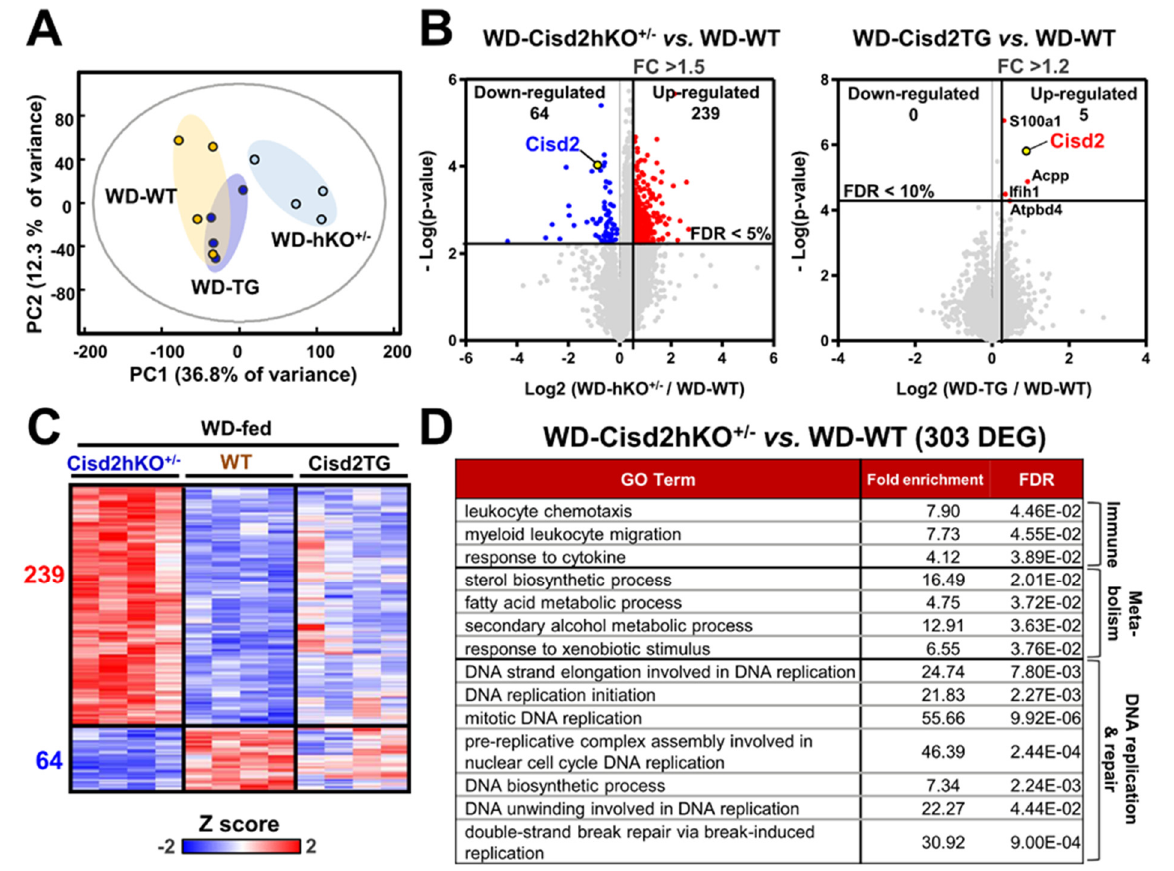
Figure 3. Cisd2 modulates hepatic gene expression profiles in WD-treated mice. ( A ) Principal component analysis (PCA) of all transcriptomic data for the 3 groups of mice (WD-fed WT, WD-fed Cisd2hKO +/ − , and WD-fed Cisd2TG mice). ( B ) Volcano plots comparing mRNA expression between Cisd2hKO +/ − vs. WT (left panel) and between Cisd2TG vs. WT (right panel). ( C ) Heatmap representing the Cisd2hKO +/ − -induced 303 DEGs. ( D ) Over-represented PANTHER GO-Slim Biological Processes of transcriptome change (303 DEGs). Top GO terms with fold enrichment above 4 are shown.